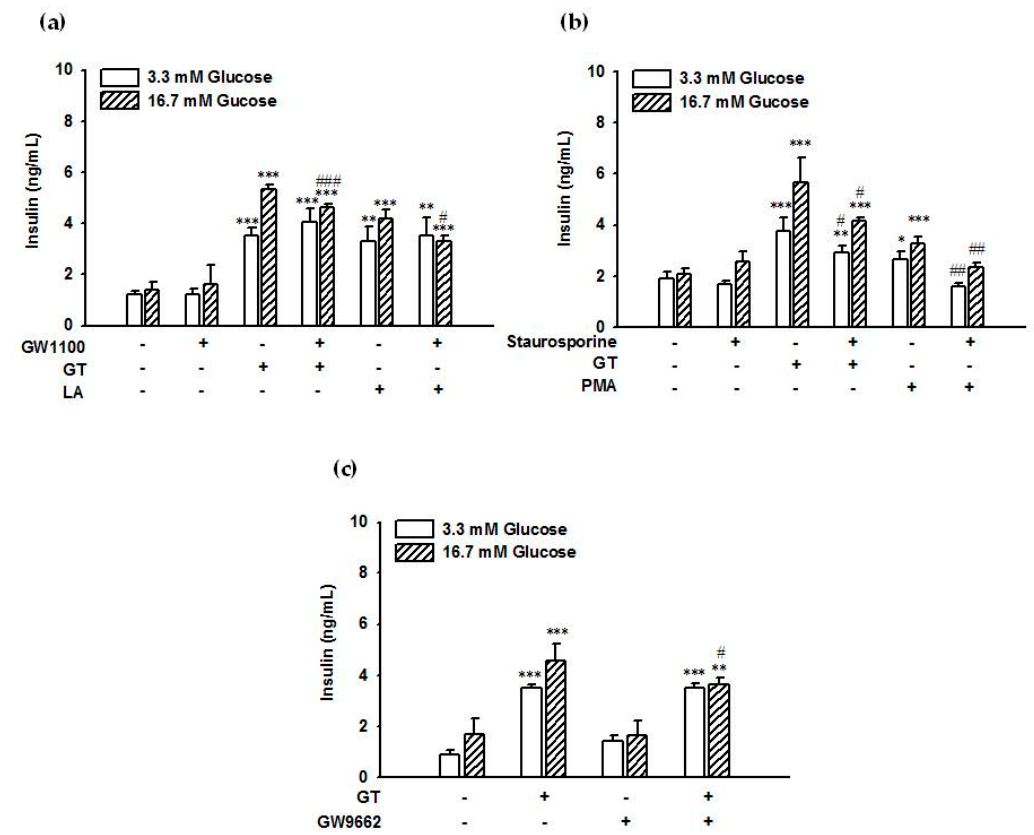
Figure 4. Inhibitory e ff ects of GPR40 antagonist, PKC, and PPAR γ inhibitors on gintonin-induced insulin secretion. Cells were incubated with gintonin (30 µ g / mL), linoleic acid (200 µ M, LA), or PMA (1 µ M) in KRB bu ff er (3.3 mM glucose or 16.7 mM glucose) in the presence or absence of the GPR40 inhibitor GW1100 (5 µ M) ( a ), the PKC inhibitor staurosporine (1 µ M) ( b ), or the PPAR γ inhibitor GW9662 (30 µ M) ( c ) for 2 h. Various agents used here were dissolved in DMSO. Insulin secretion was measured using an insulin ELISA kit, as described in Materials and Methods. Data represent means ± SD ( n = 4 to 6); * p < 0.05, ** p < 0.01, *** p < 0.001, vs. control (Con). # p < 0.05, ## p < 0.01, ### p < 0.001, vs. GT alone. GT, gintonin; LA, linoleic acid; PMA, phorbol 12-myristate 13-acetate; PKC, protein kinase C; PPAR γ , peroxisome proliferator-activated receptor γ .